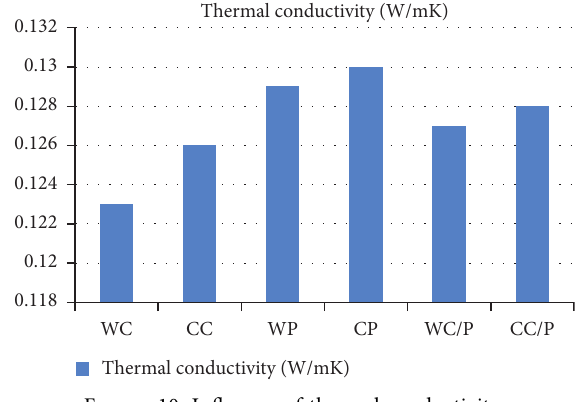
Figure 10: Influence of thermal conductivity.